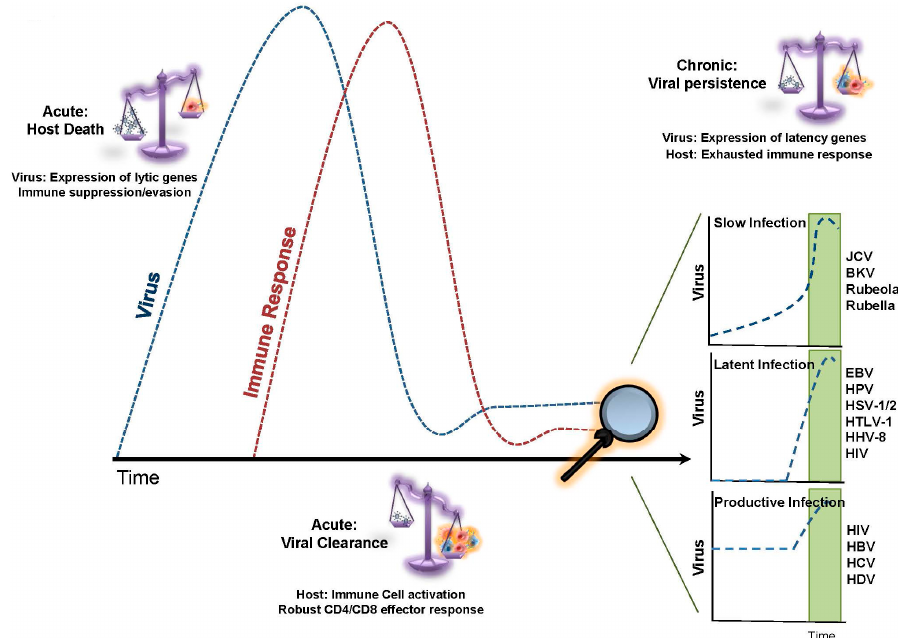
Figure 1. The relationship between host immune response and the invading virus during the course of acute or chronic viral infection. During acute viral infection, the balance swings in favor of viral production, leading to the expression of viral genes and rapid viral replication. The conclusion often involves either host death (enhanced viral replication; dotted blue line) or viral clearance (enhanced immune response; dotted red line). The latter involves a robust immune effector response from CD4+ and CD8+ T cells and the development of immune memory. During chronic viral infections, there is a balance between virus replication and host immune response, leading to persistence of the virus. On the part of the virus, this often involves suppression of viral lytic genes in favor of viral latency genes. The immune response is often impaired, due to a reduction in host adaptive immune responses and chronic T-cell exhaustion. Chronic viral infections are categorized as either slow, latent, or